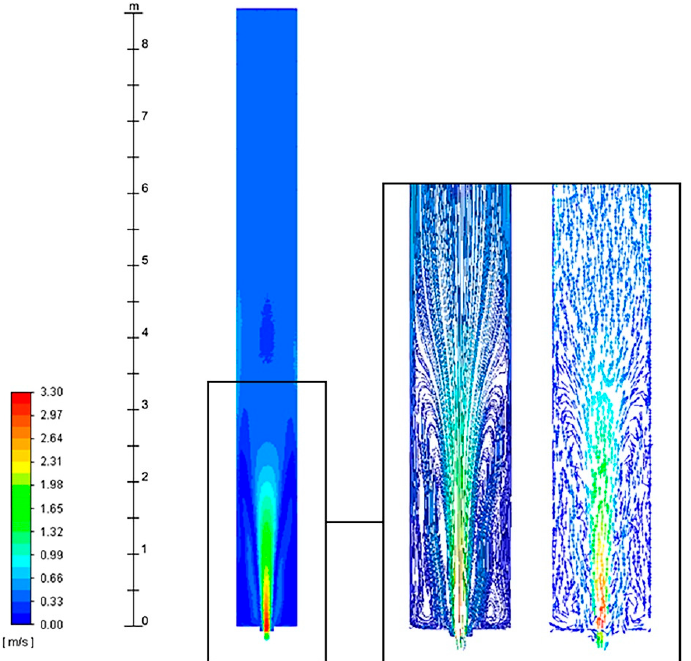
Figure 14. Air velocity profile inside the naturally ventilated cavity at 4:00 p.m., plotted on a sur- face at half the thickness of the cavity.